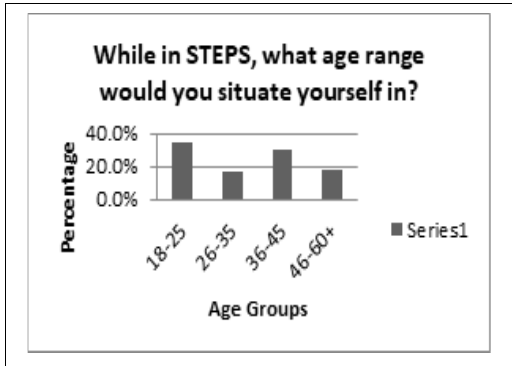
Figure 1. Age range of participants in online